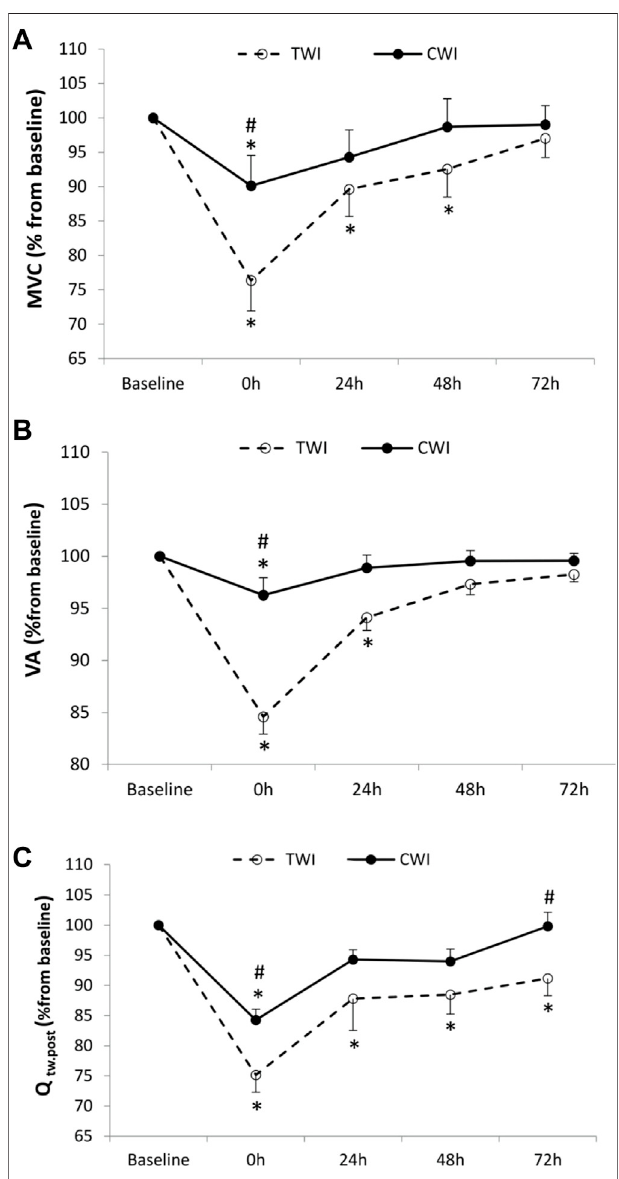
FIGURE 2 | Maximal voluntary contraction (MVC) (A) , Voluntary activation(VA) (B) ,andquadricepspotentiatedtwitchforce(Q tw,pot ) (C) values measured at baseline and following the match (post, 24h, 48h and 72 h) after cold water immersion (CWI) or thermoneutral water immersion (TWI). *Signi fi cant difference in comparison to baseline ( p < 0.05). # Signi fi cant difference in comparison to TWI ( p < 0.05).